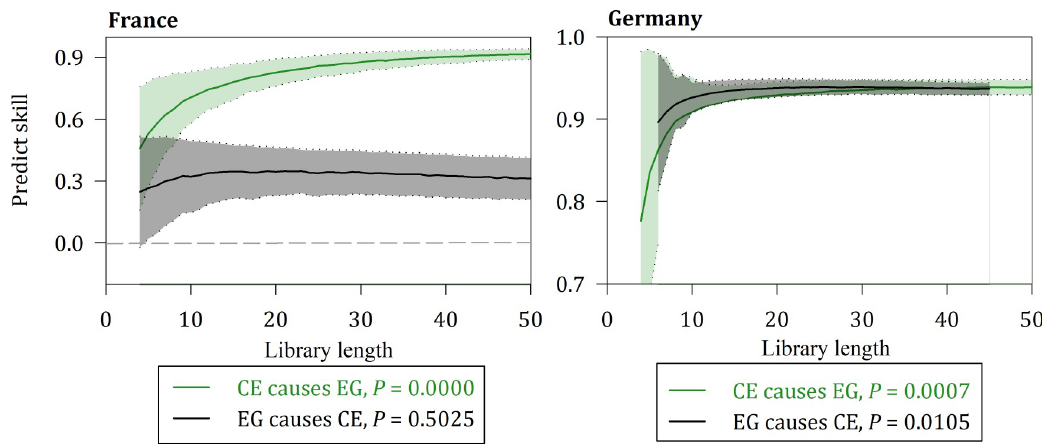
Fig 7. Causality between CE and EG for France and